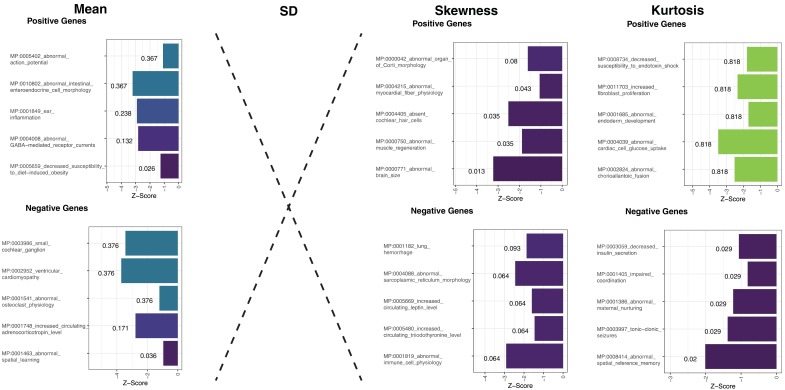
Gene ontology analyses from baseline profiles of the four moments of the intensity distribution.Results from this spatial overlap analysis show no clear or unique ontological profile for any of the genes and when p-values were corrected for FDR across the four moments and positive and negative gene-lists, none survived correction.